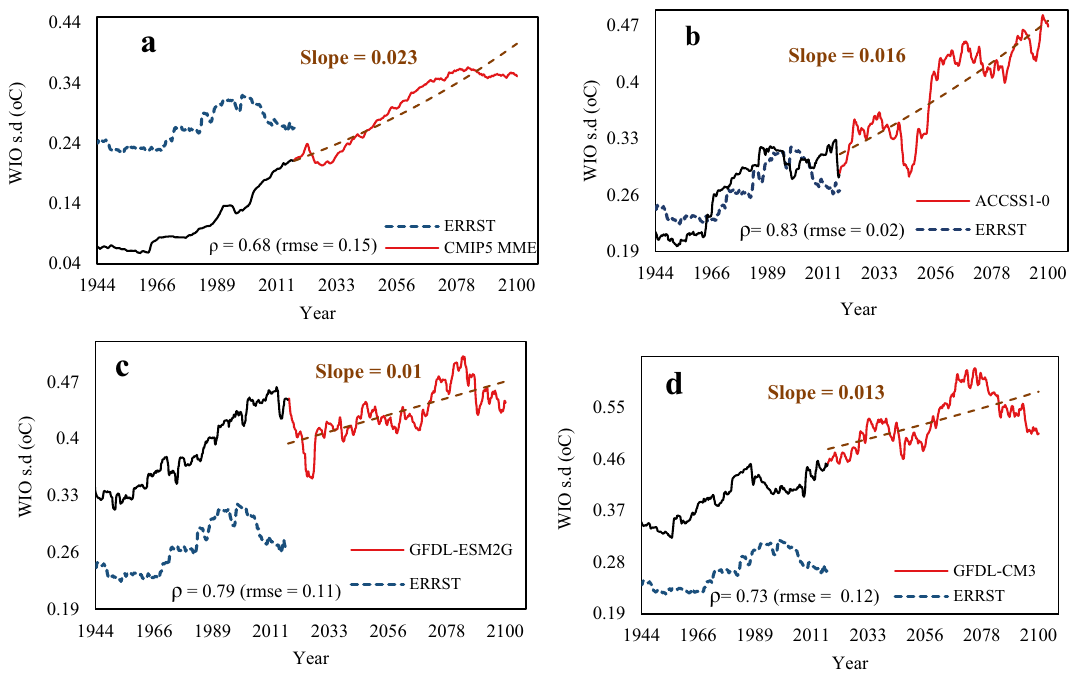
Figure 13. Time variation of simulated WIO amplitude. ( a ) the multi-model ensemble (MME) of the WIO amplitude from 34 climate models computed over 30-year running periods from 1913 to 2100. The WIO from the MME was calculated as area weighted average of the Indian Ocean SST over the Arabian sea (50° E–70° E and 10° S–10° N) in each model simulations. The 30-year running WIO amplitudes from ERSST over the period 1913–2017 are also shown (blue). Pearson correlation coefficients between the best models and observations (ERSST data), are displayed. The slope is the linear trend estimated at the 5% level based on the Mann–Kendall test. WIO estimated from the GCM that best agrees with the observed WIO were selected. The correlation between the MME of WIO obtained from GCMs and WIO estimated from ERSST data range between ρ = 0.61 and ρ = 0.88 ( a – d ). In ( a – d ), the variability (s.d.) of WIO has increased since the 1970s in both the observed dataset and the MME of 34 GCMs’ simulations for the historical run, which means that the western Indian Ocean has become warmer, and projected to be much warmer, at a warming trend of 0.01–0.023 °C/decade between 2019 and